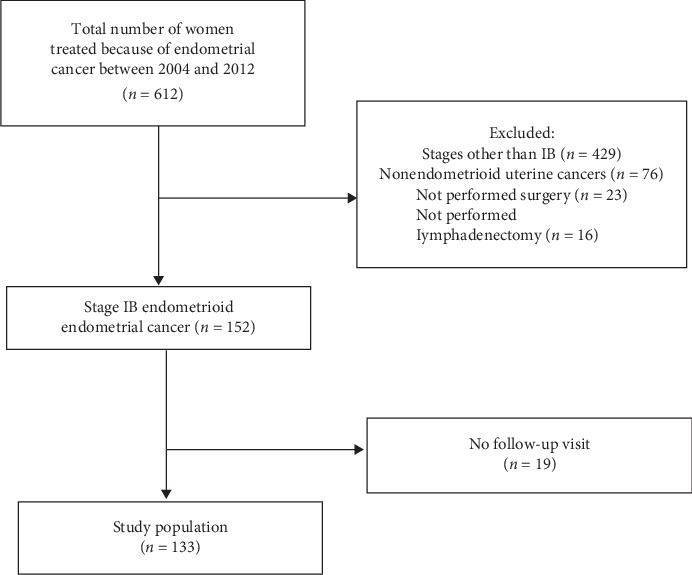
Study population.